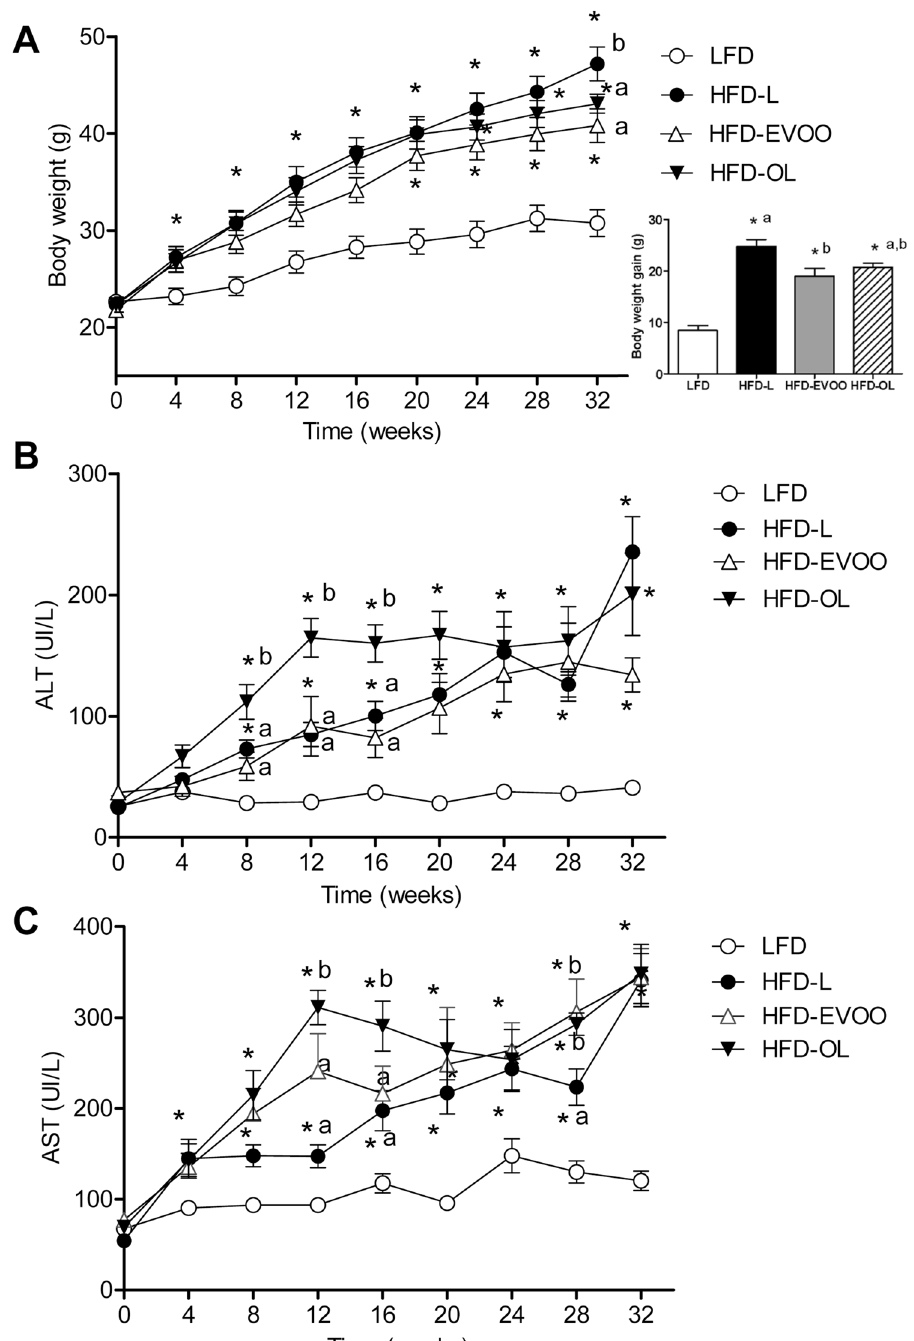
Figure 1. Body weight and transaminases (ALT and AST) values along the nutritional intervention study. ( A ) Left panel: BW during the 32 weeks of the nutritional intervention study (n = 17); Right panel: BW gain between the first and the last week of the study. ( B ) ALT and ( C ) AST values measured during the study (n = 7). Values are the means ± SEM. *p < 0.05 LFD vs HFDs groups (HFD-L, HFD-EVOO and HFD-OL); different letters indicate significant differences among HFD groups ( p <